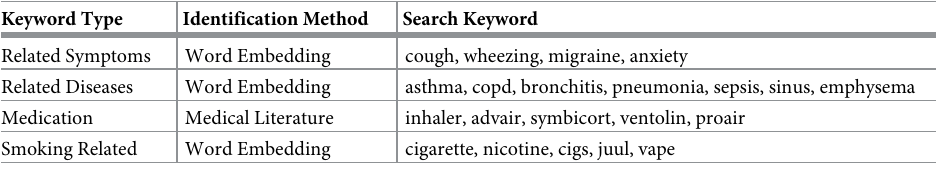
Table 1. Subset of keywords used to generate estimates of respiratory